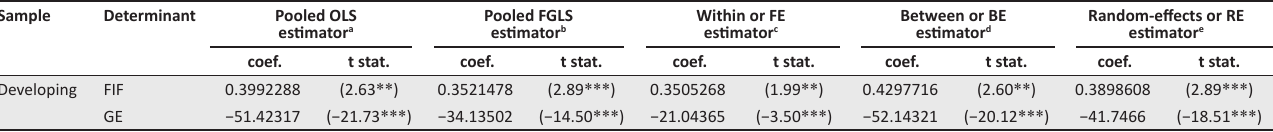
TABLE 13: Variation of corruption depends on fiscal freedom variable and government effectiveness, by level of development: Developing. Sample Determinant Pooled OLS